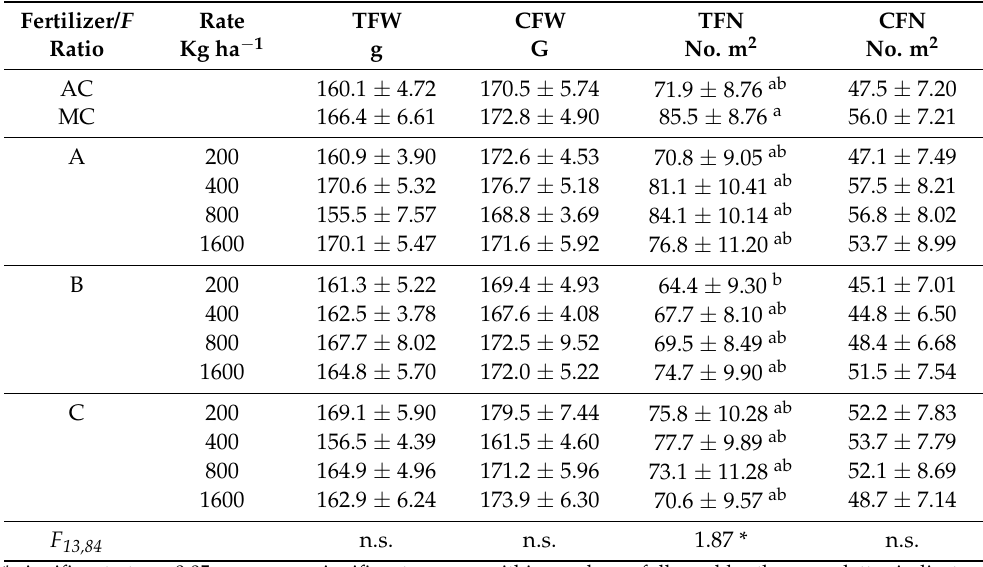
Table 6. Effect of bio-fertilizer application on weight and numbers of tomato fruits (mean ± stan- dard